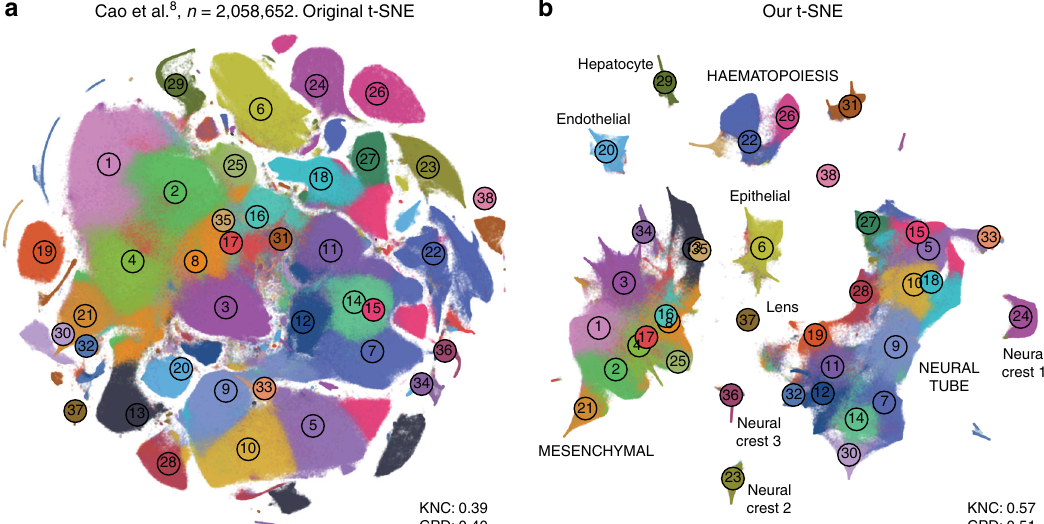
Fig. 9 Cao et al. data set. Sample size n ¼ 2 ; 058 ; 652. Cluster assignments and cluster colours are taken from the original publication 8 . a T-SNE